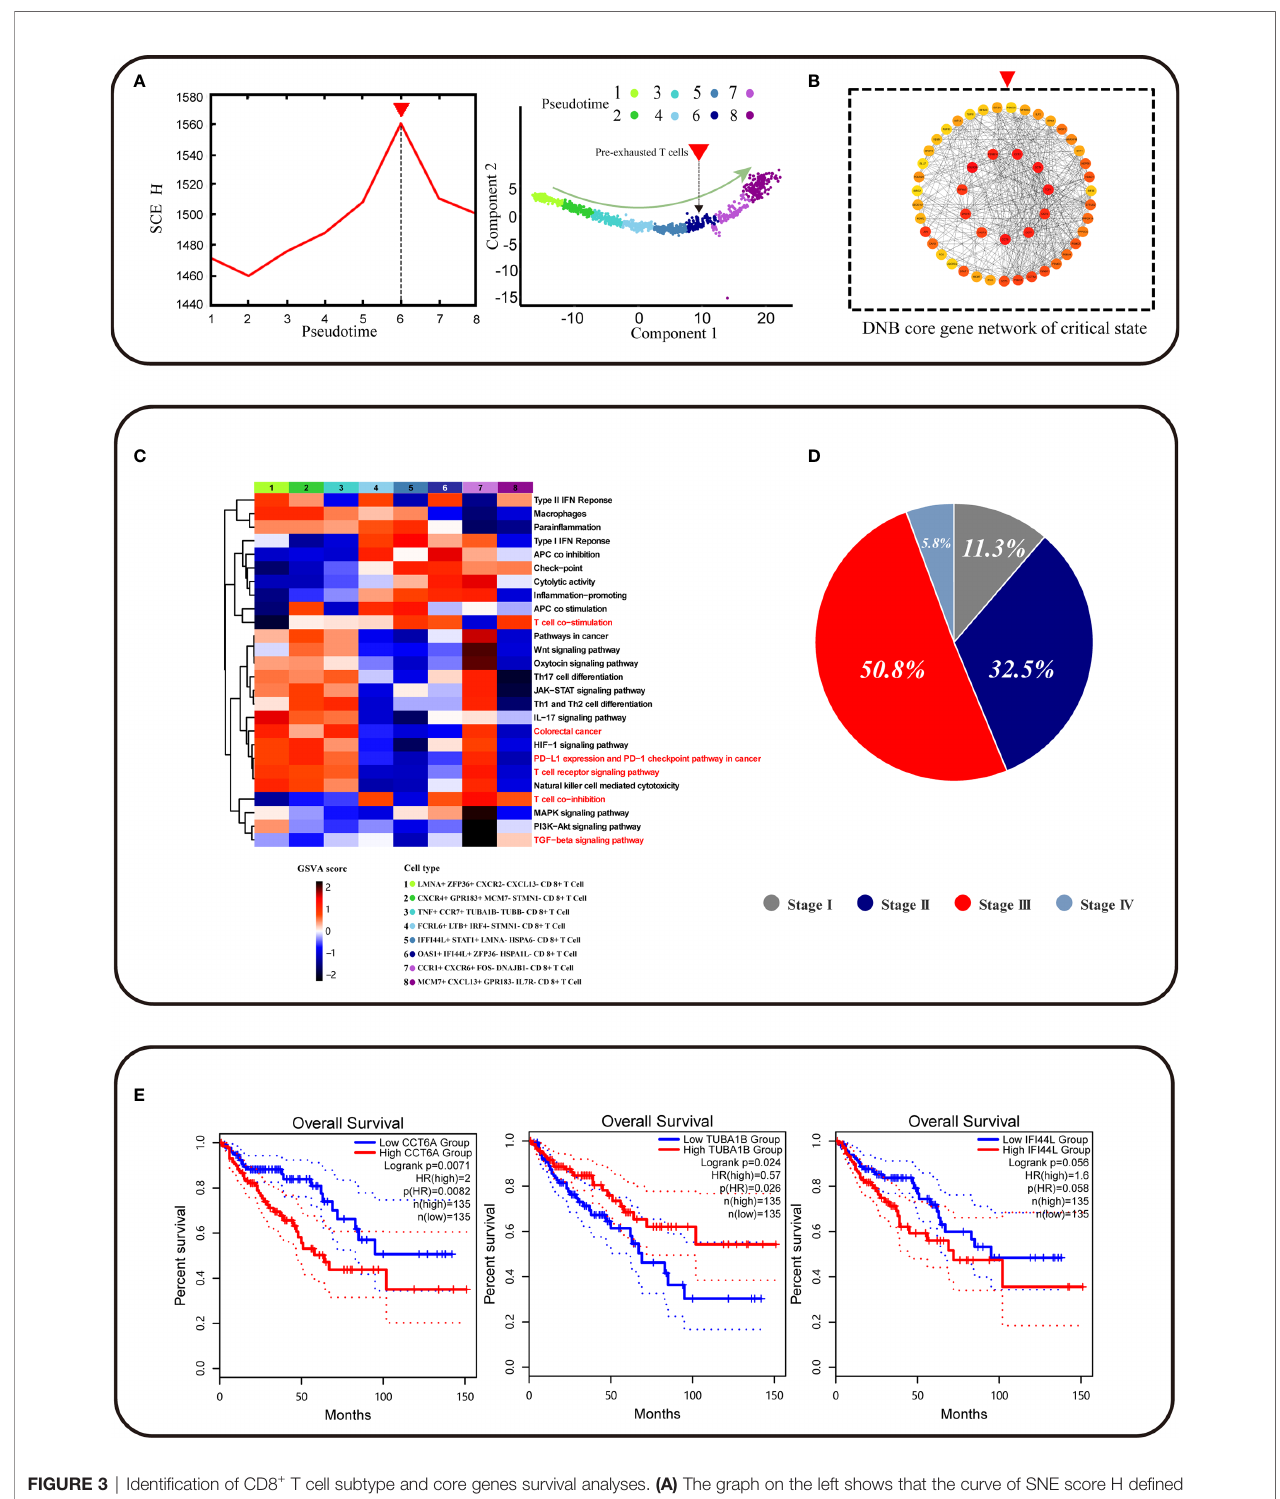
FIGURE 3 | Identi fi cation of CD8 + T cell subtype and core genes survival analyses. (A) The graph on the left shows that the curve of SNE score H de fi ned in Methods suddenly increases when the system is near the critical point (p = 0), which is viewed as a critical state transition at a bifurcation point. The graph on the right shows that pre-exhausted T cells were at critical state and CD8+ T cell developmental trajectory is same as Figure 2C . (B) The graph represents the gene regulatory network for the DNB core genes. (C) Function analysis (GSVA) shows that different gene sets may play a different role in CD8 + T cell exhaustion progress. (D) Pie chart representing the proportion of patients associated with different periods of colorectal cancer. (E) CCT6A TUBA1B IFI44L survival analyses using the TCGA COAD